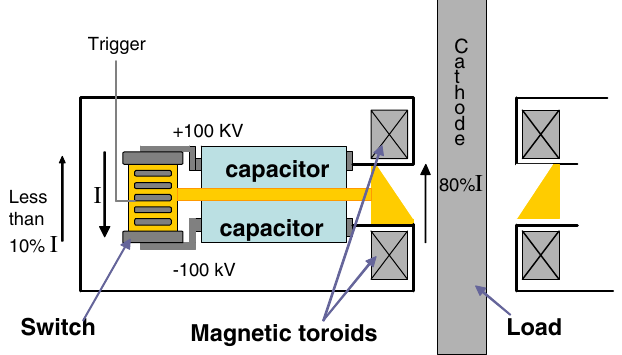
FIG. 1. Schematic of an LTD brick showing DC-charged capacitors, a triggered switch, and